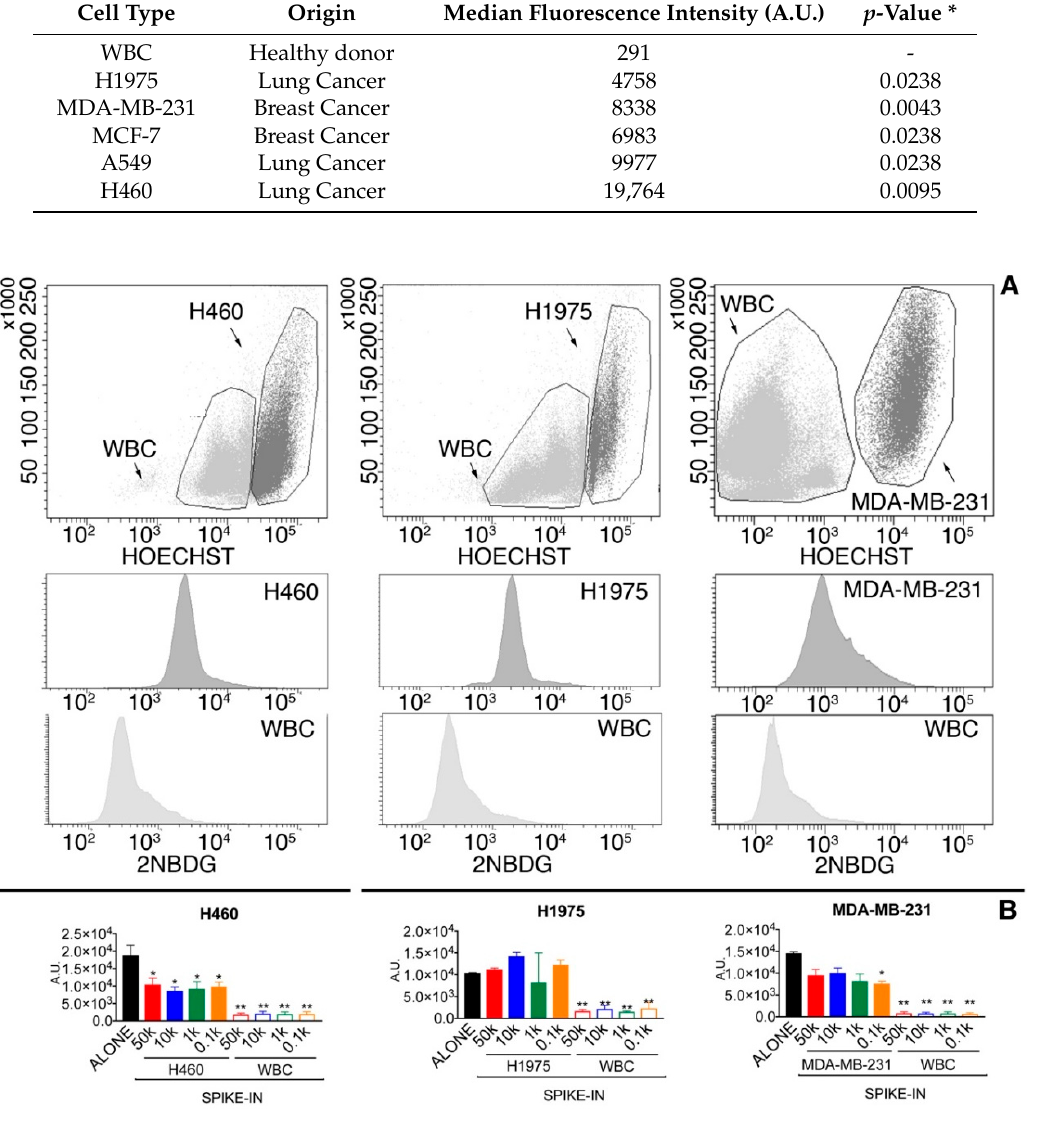
Figure 2. ( A ) Glucose uptake of tumor cells and WBC in spike-in samples. Representative images of spike-in samples (50,000 cells) of H460, H1975, and MDA-MB-231 in WBC. In the upper panels, SSC/Hoechst dot-plots were used to discriminate tumor cells (Hoechst(+), dark grey) from WBC (Hoechst( − ), light grey). In the lower panels are presented the histograms showing the 2-NBDG positivity of tumor cells (middle panels) and WBC (lower panels), respectively; ( B ) glucose uptake in tumor cells alone and in spike-in samples. Data are presented as median and interquartile range. Black columns indicate the glucose uptake of tumor cells alone. All the other solid columns refer to different spike-in sample in which 50,000 (50k), 10,000 (10k), 1000 (1k), and 100 (0.1k) tumor cells were spiked into peripheral blood samples. The last four columns indicate the glucose uptake of WBC in the 50k, 10k, 1k, and 0.1k spike-in samples. *, p < 0.005 of tumor cells in spike in sample with respect to cells alone (Kruskal–Wallis test followed by Dunn’s post-test). **, p < 0.05 of WBC versus the tumor cells of the corresponding spike-in sample (Mann–Whitney